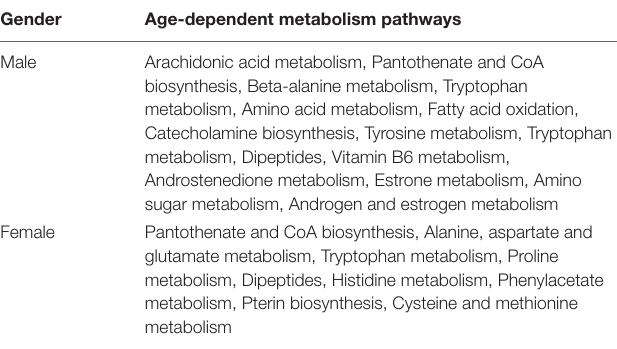
TABLE 3 | Age dependent metabolism pathways in male and female children. Gender Age-dependent metabolism